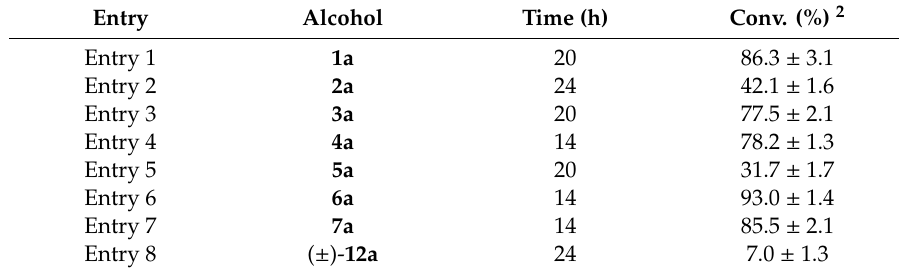
Scheme 1. Oxidation of aromatic alcohols 1-12a catalyzed by HMFO in non-conventional media aqueous bu ff er; natural (NA)deep eutectic solvents (DESs). Table 1. 5-hydroxymethylfurfural oxidase (HMFO)-biocatalyzed oxidations of aromatic alcohols (Tris/HCl 50 mM, pH 8.0, 30 °C) 1 .